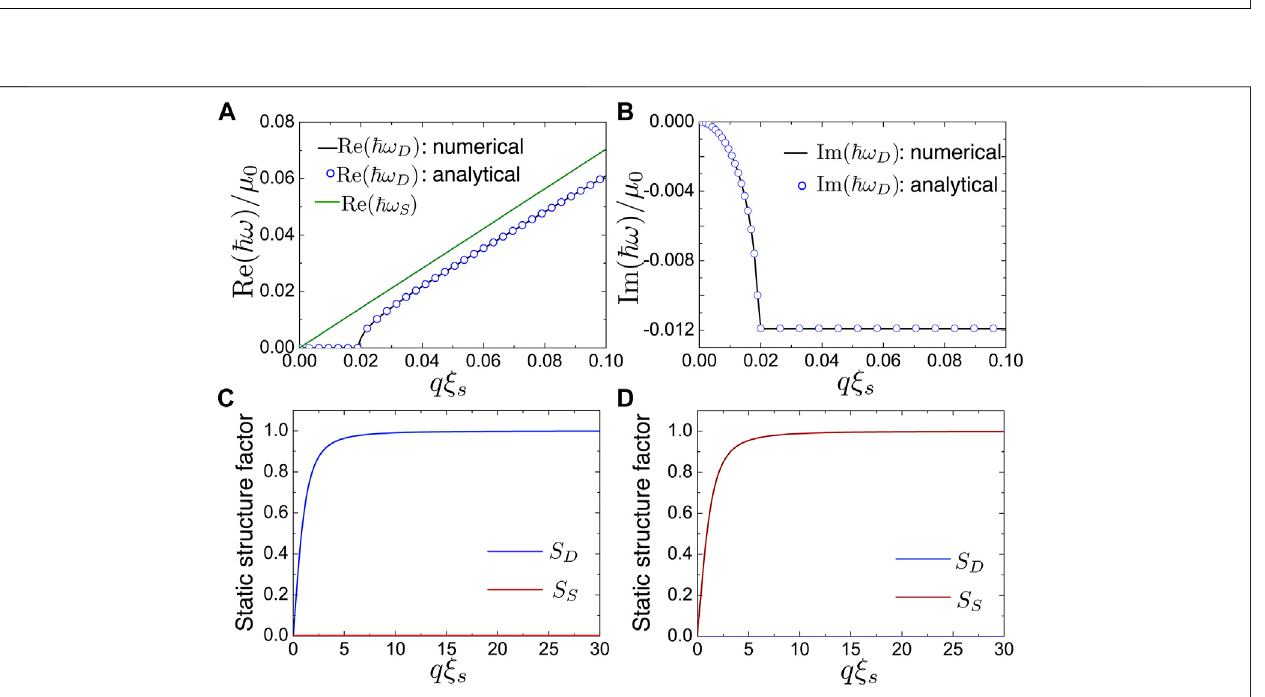
FIGURE2| PropertiesofDMS. (A) Density ofeach component, n 1 (cid:1) n 0 (1+ δ n 1 )/2and n 2 (cid:1) n 0 (1 − δ n 2 )/2(see Eqs. 6 , 7 ),inspace andtime. (B) Spatialdistribution of n 1 , n 2 ,thelinearpolarizationangle φ r, andtheglobalphase φ g ,atadimensionlesstime t / τ (cid:1) 15.Toppanel: n 1 and n 2 ;bottompanel: φ r and φ g .Inbothpanels,analytical results are compared to numerical solutions of Eqs. 1 – 3 . (C) Polarization texture. Top panel: schematics in the stationary case. Bottom panel: Stokes parameters for a